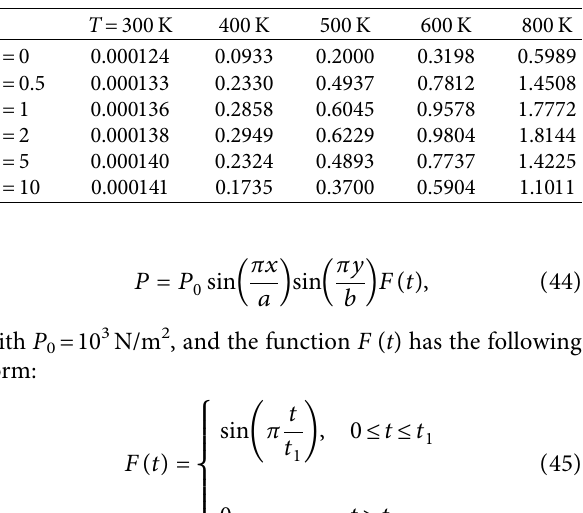
Table 9: Maximum deflection w c (mm) depending on n and temperature, Si 3 N 4 /SUS304, G v � 2.10 − 4 .